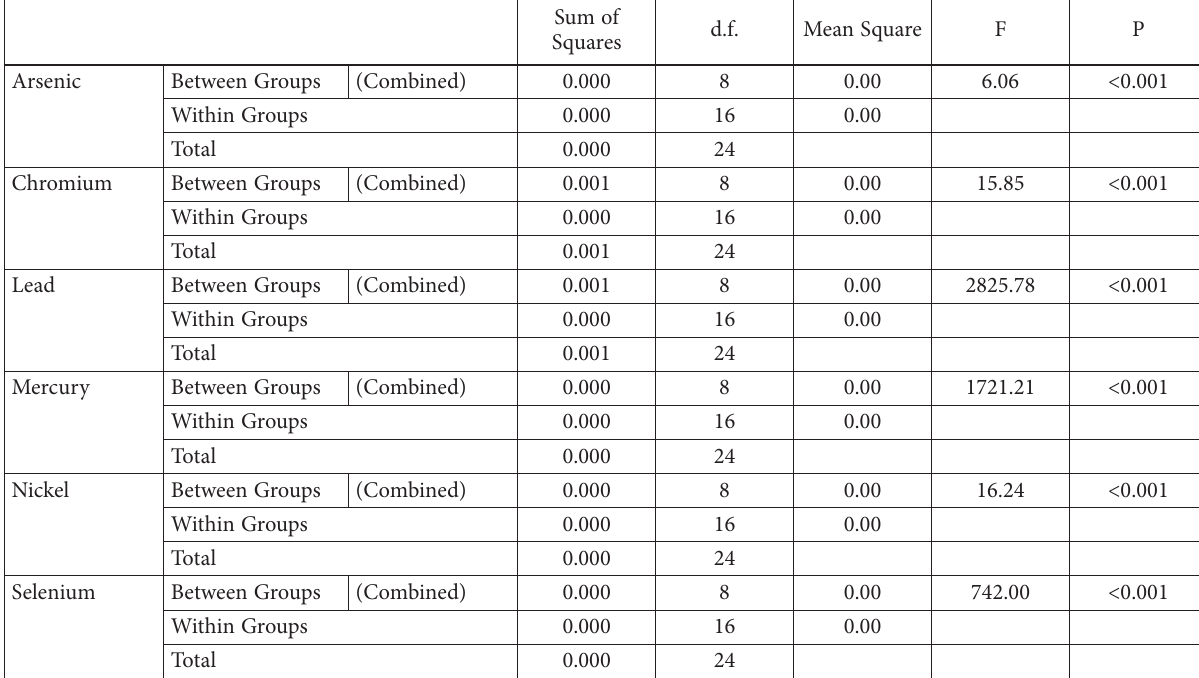
Table 11. ANOVA of the heavy metal data Sum of